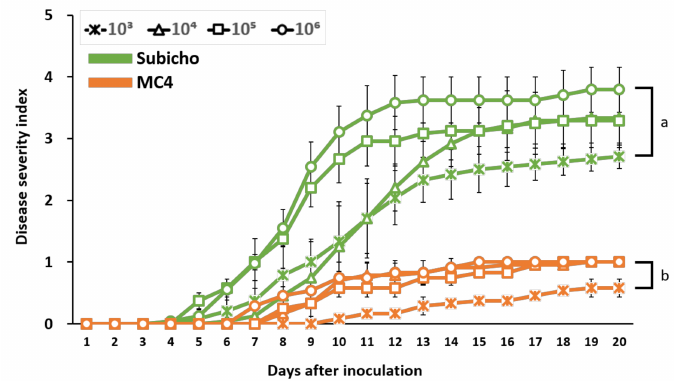
Figure 4. Occurrence of bacterial wilt on seedling of two pepper cultivars according to inoculum concentration. Three weeks after transplanting, the eight-leaf stage seedlings were inoculated with R. solanacearum SL1931 with bacterial suspensions (1 × 10 3 , 1 × 10 4 , 1 × 10 5 , and 1 × 10 6 CFU/mL) to give inoculum volume of 0.1 mL/leaf. Disease severity of the plants was investigated every day after inoculation. Green and orange lines indicate ‘Subicho’ and ‘MC4 (cid:48) , respectively. Each bar represents the S.E from three independent experiment with 24 plants. Values in the labeled with the same letter within each inoculum concentration are not significantly different in Duncan’s multiple range test at p = 0.05. Int. J. Mol. Sci. 2021 , 22 , x FOR PEER REVIEW 7 of 15